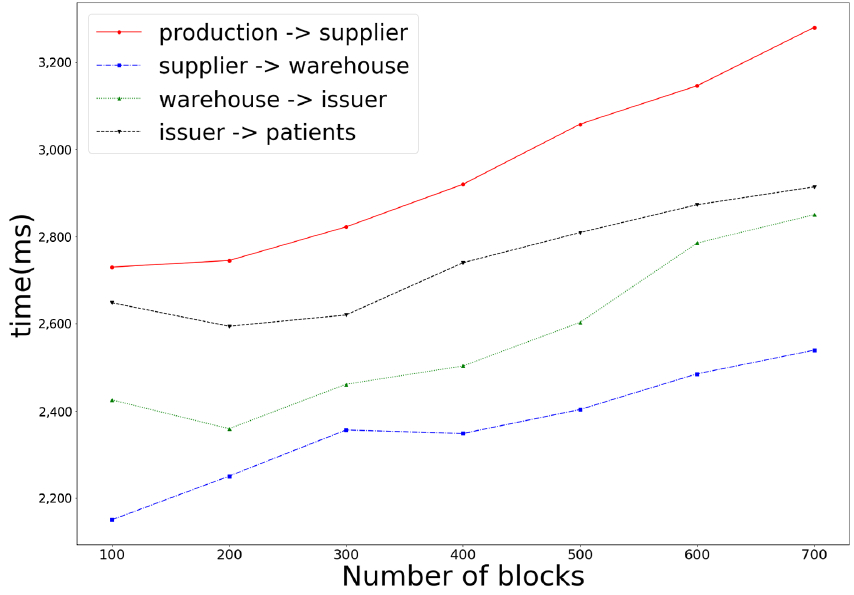
Figure 8. Total transaction processing